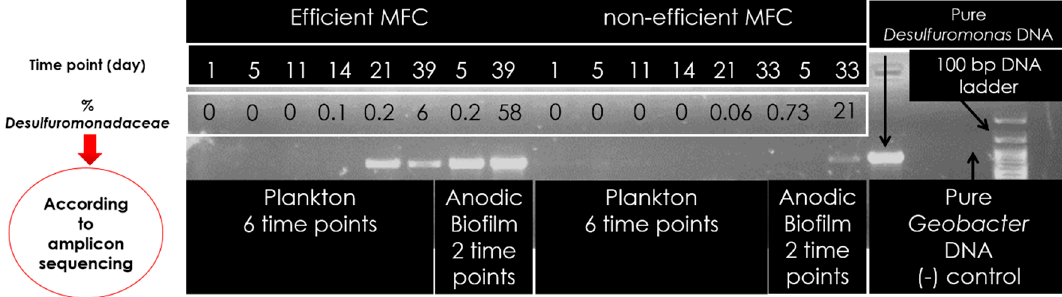
Figure 4. PCR products obtained with the specific 16S ‐ Desulfuromonadaceae primers for efficient and non ‐ efficient MFCs. Relative abundance of Desulfuromonadaceae according to amplicon sequencing is shown. Last lane from the left is a 100 bp size ladder.